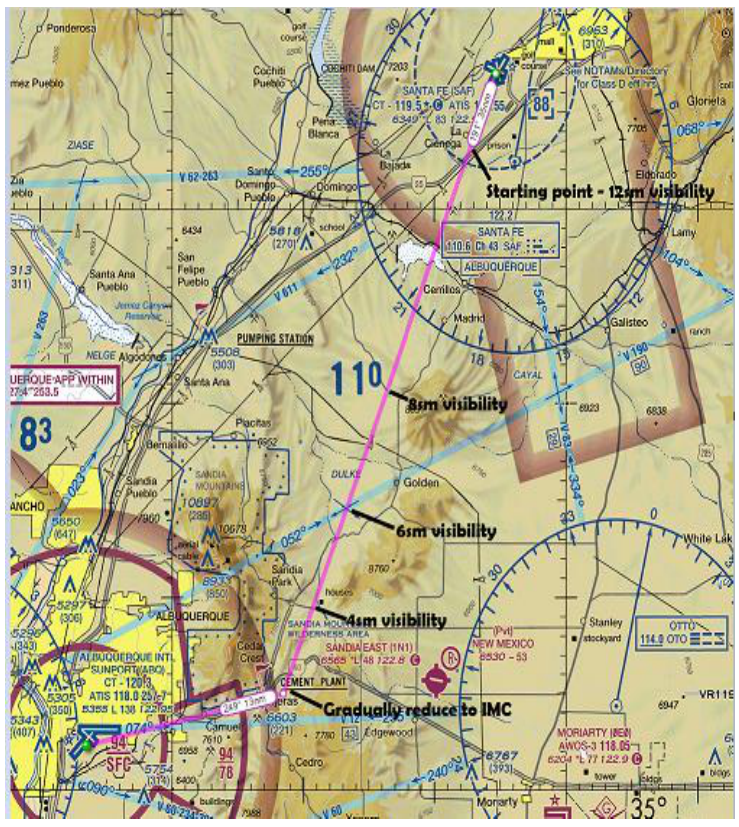
Figure 2. Aeronautical map of the Santa Fe, New Mexico (KSAF), to Albuquerque, New Mexico (KABQ), flight plan. Table 2. Timeline of flight scenario events.